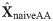
Model overview figure.SPURF uses a per-site linear combination of substitution profiles from diverse sources to predict complete substitution profiles from a single member of a CF. At the top are the different profiles that serve as inputs to the model, some directly related to the naive sequence (X^naiveAA and X^neut), and others partitions of the public Rep-Seq datasets (X^vgene and X^vsubgrp). To predict a substitution profile, a weighted average is taken over the input sequence X and external profiles X*={X^naiveAA,X^vgene,X^neut,X^vsubgrp} (see the dashed line bubble). The vertical blue arrow indicates that the weighted average (in the dashed line bubble) occurs at each of the 149 AHo positions. Once a predicted profile is generated, this is compared to ground truth using either L2 error or Jaccard similarity as a performance metric. The α vectors are estimated by optimizing the objective function, which also includes a statistical regularization term to prevent overfitting.